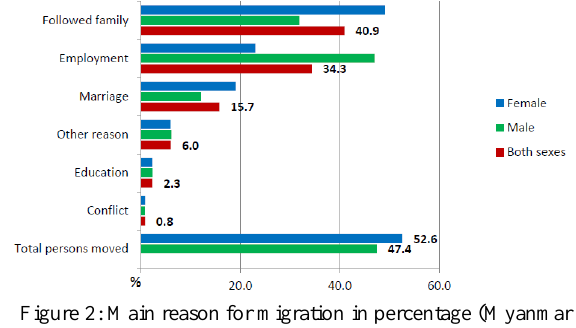
Figure 2: Main reason for migration in percentage (Myanmar Census, 2014b)